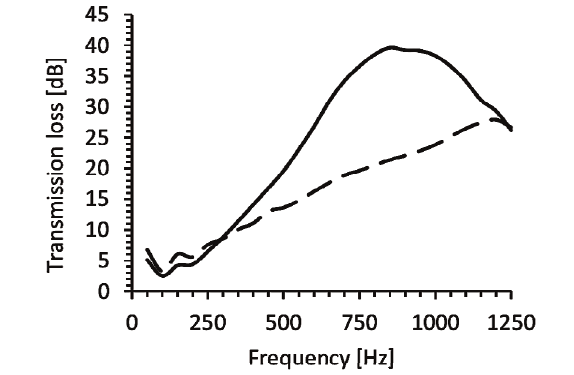
Fig. 18. Transmission loss measured for the proposed layout and compared with a market average.